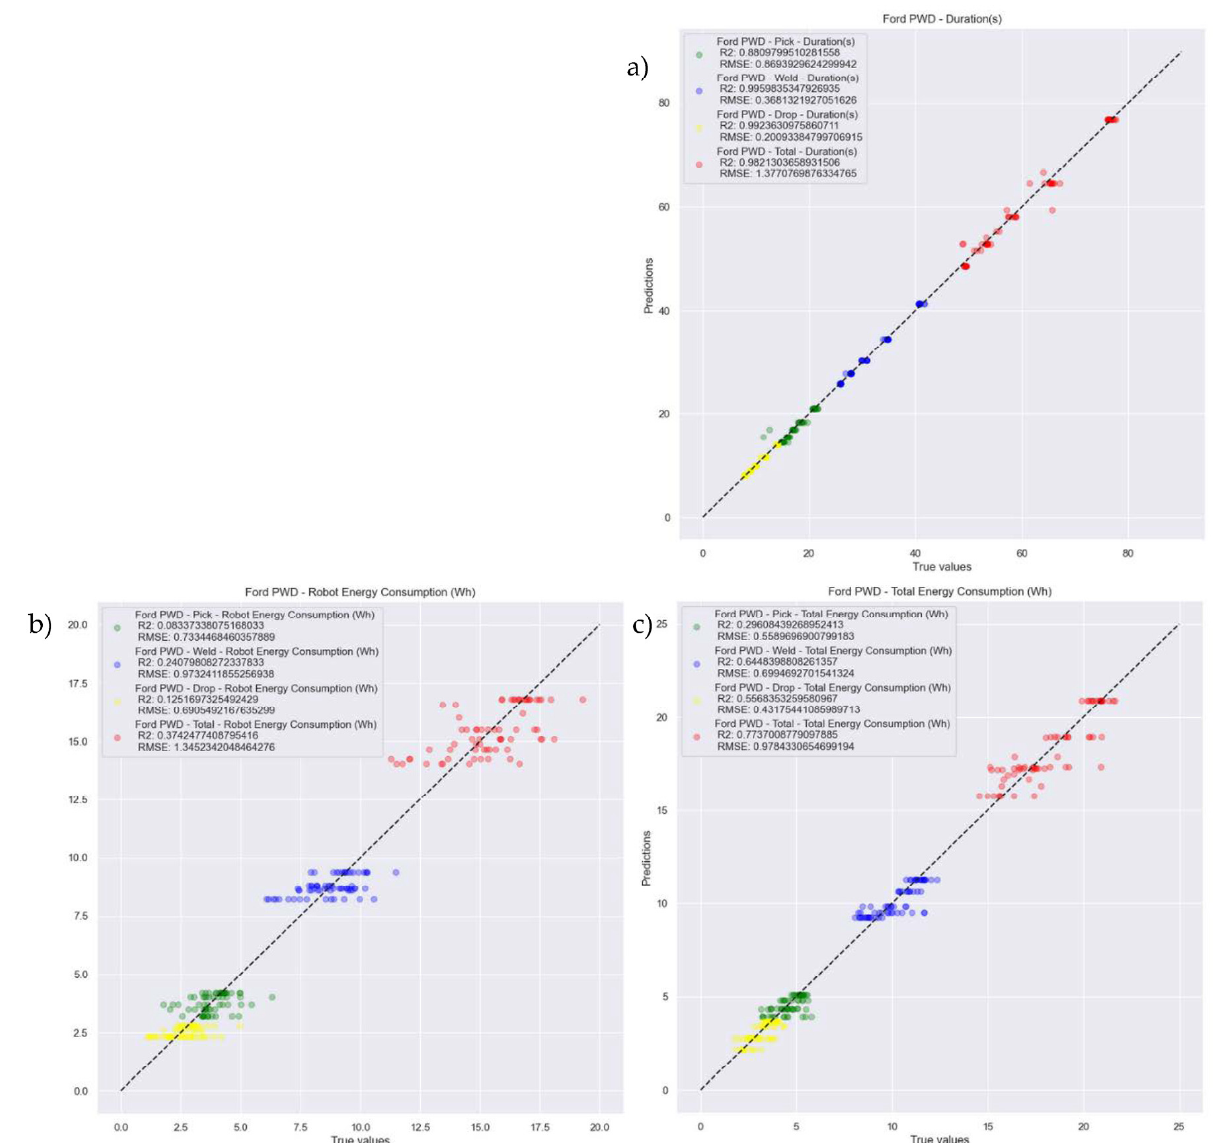
Figure 11. Predictions (y) versus True Values (X) for the Ford_PWD predictive model, being ( a ) the duration, ( b ) the robot energy consumption and ( c ) the total energy consumption.